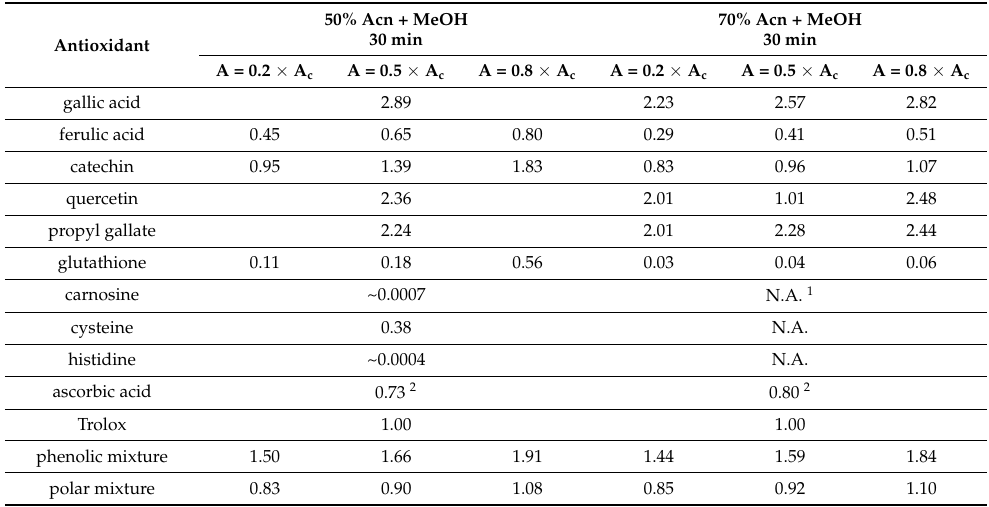
Table 11. TEAC values determined against DPPH radicals applied in aqueous acetone (radical solution in methanol) after standard reaction time.